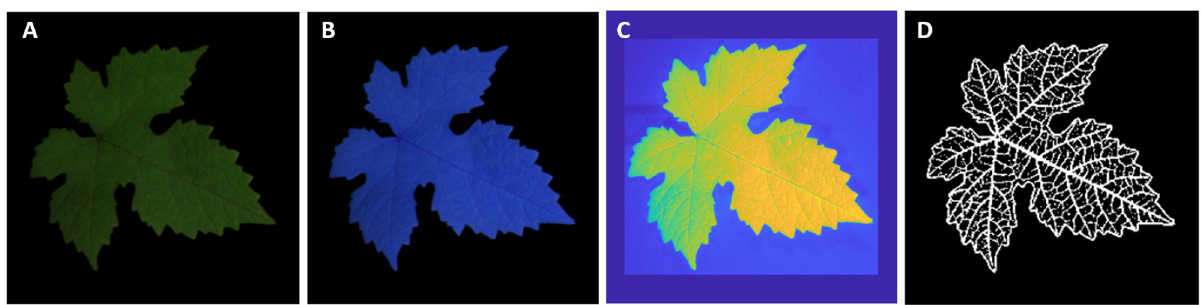
Fig 1. Sample of grapevine leaf from the dataset. A: RGB image; B: RGNIR image; C: normalized and cropped NIR image; D: companion skeleton. In the skeleton binarized image, the white color identifies the leaf profile and veins, the black color identifies other parts of the leaf and the background.